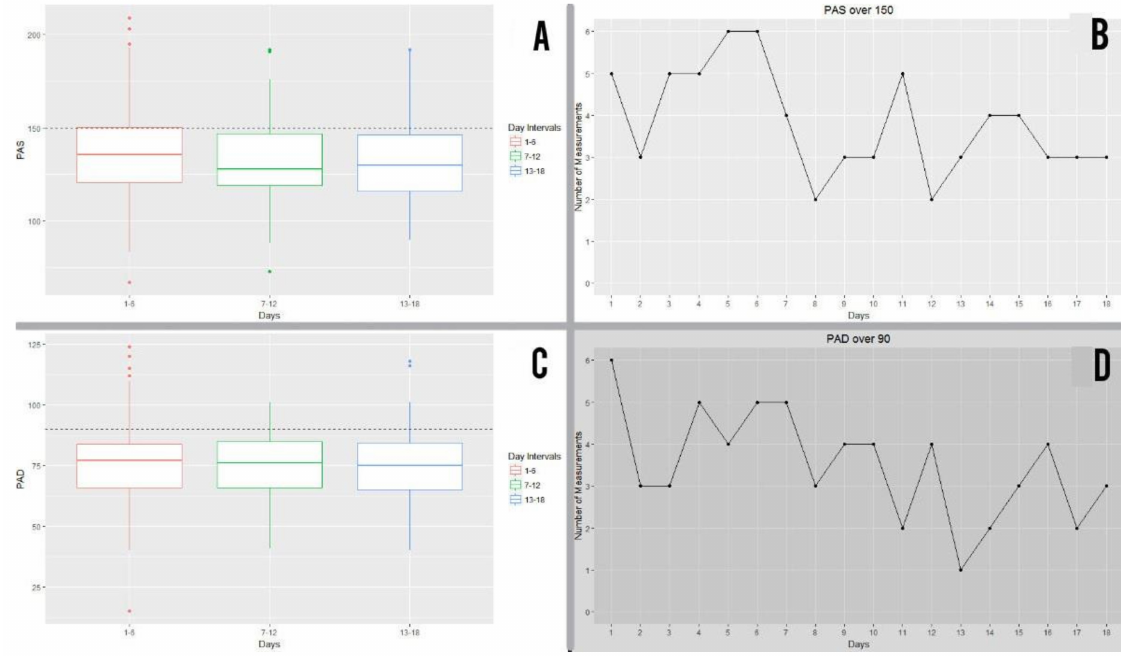
Figure 11. ( A ) Results of systolic blood pressure (SBP) for the study group during exercise, grouped together into 6-day intervals. ( B ) Number of systolic blood pressure (SBP) measurements which were above the cut-off point per day. ( C ) Results of diastolic blood pressure (DBP) for the study group during exercise, grouped together into 6-day intervals. ( D ) Number of diastolic blood pressure (DBP) measurements which were above the cut-off point per day.